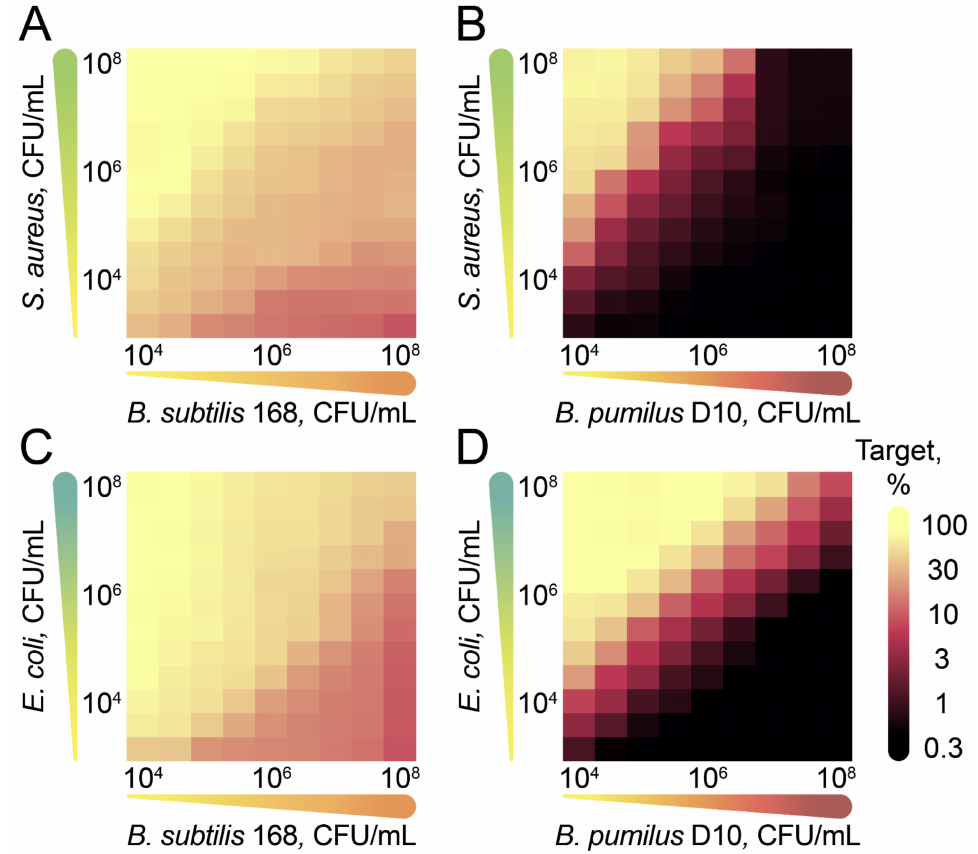
Figure 4. Antimicrobial activity landscapes of B. pumilus D10. Reporter S. aureus ( A , B ) and E. coli ( C , D ) were cocultivated with effector strains using various cell ratios. Effector B. subtilis 168 strain was used as a negative control. Target was analyzed by fluorescence of culture after 24 h of cocultivation. Heatmap indicates maximal target proliferation estimated by relative fluorescence